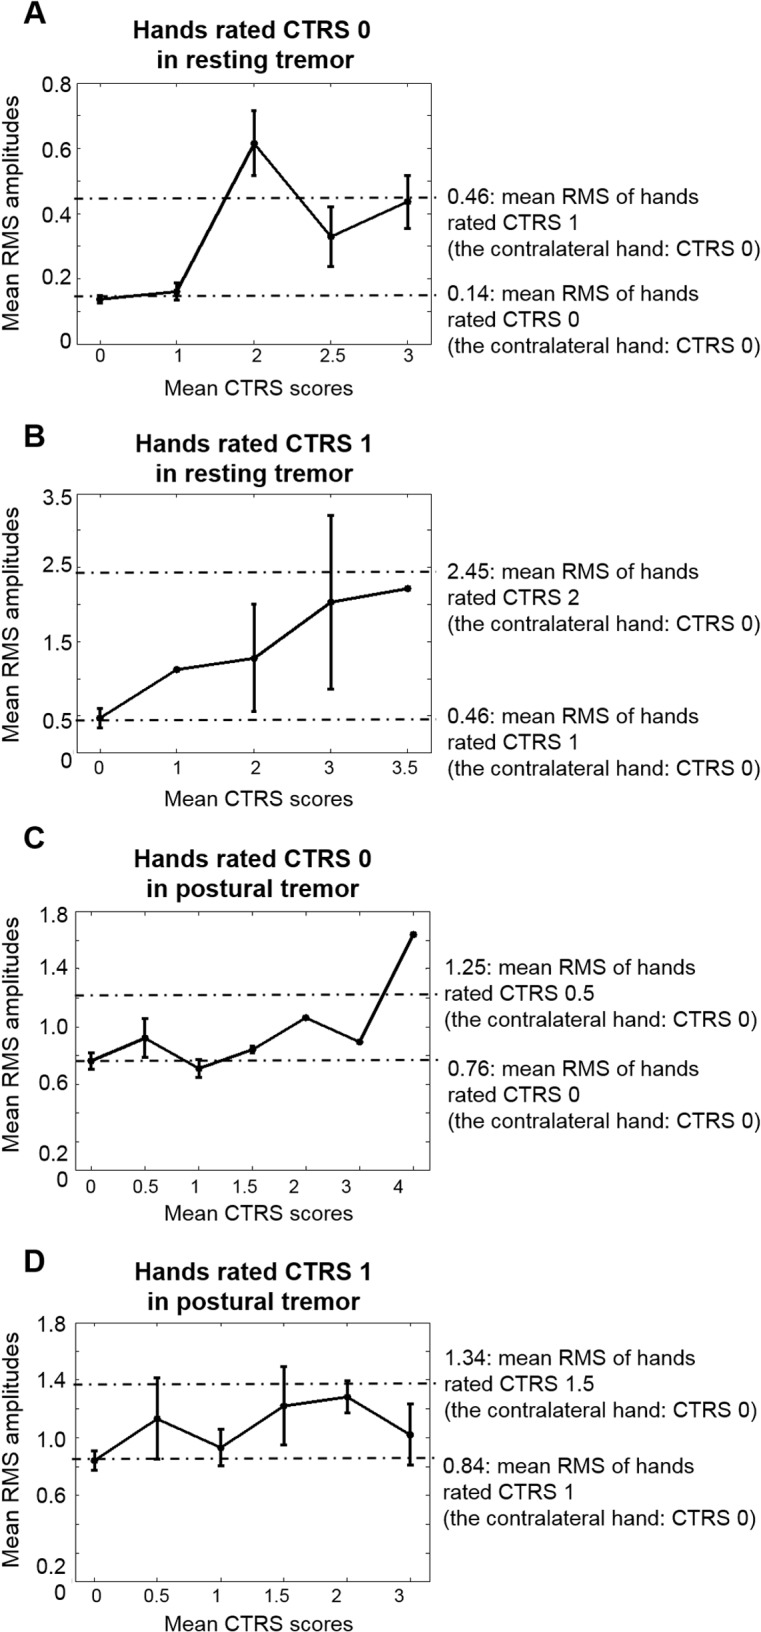
Mean RMS amplitudes in Session I.The mean RMS amplitudes and standard errors of the hands rated with the same CTRS score, across the severity of the contralateral hand. (A) The mean RMS amplitudes of the hands rated CTRS 0 in resting tremor were 0.14 ± 0.04, 0.16 ± 0.05, 0.62 ± 0.34, 0.33 ± 0.20, and 0.44 ± 0.21 when the contralateral hand’s severity ratings were 0, 1, 2, 2.5, and 3, respectively. (B) The mean RMS amplitudes of the hands rated CTRS 1 in resting tremor were 0.46 ± 0.27, 1.12 ± 0.00, 1.28 ± 1.02, 2.03 ± 1.66, and 2.21 ± 0.00 when the contralateral hand’s severity ratings were 0, 1, 2, 3, and 3.5, respectively. (C) The mean RMS amplitudes of the hands rated CTRS 0 in postural tremor were 0.76 ± 0.18, 0.92 ± 0.30, 0.71 ± 0.20, 0.84 ± 0.03, 1.06 ± 0.00, 0.89 ± 0.00 and 1.64 ± 0.00 when the contralateral hand’s severity ratings were 0, 0.5, 1, 1.5, 2, 3, and 4, respectively. (D) The mean RMS amplitudes of the hands rated CTRS 1 in postural tremor were 0.84 ± 0.21, 1.13 ± 0.63, 0.93 ± 0.18, 1.22 ± 0.47, 1.28 ± 0.22, and 1.02 ± 0.37 when the contralateral hand’s severity ratings were 0, 0.5, 1, 1.5, 2, and 3, respectively.